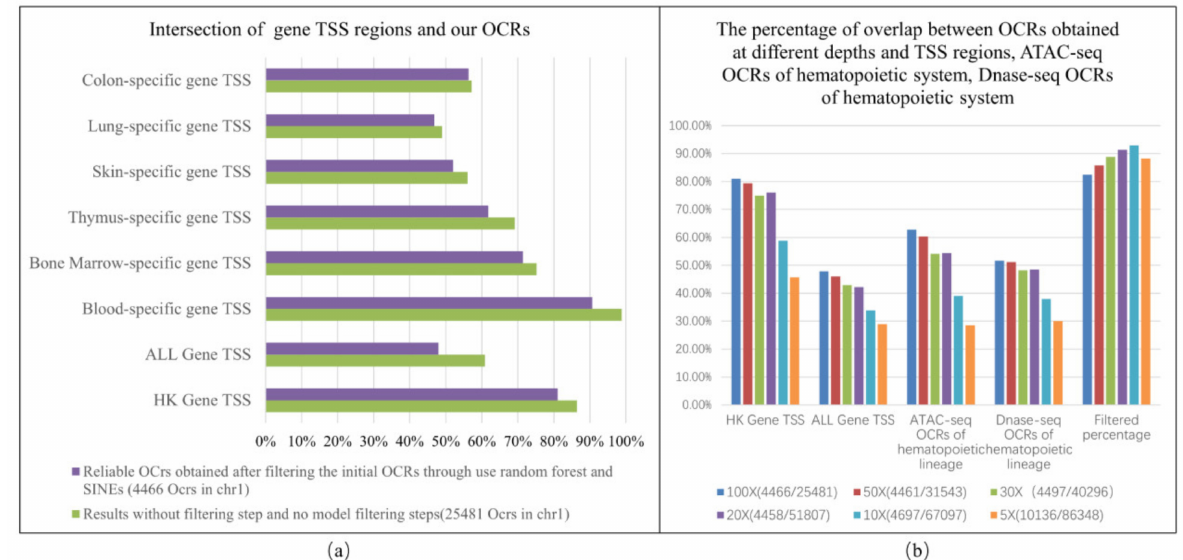
Figure 3. ( a ) The intersection of gene TSS regions and OCRs obtained under different filter conditions. ( b ) The percentage of overlap between our OCRs obtained at different coverages and TSS regions, the ATAC-seq OCRs of the hematopoietic system, and the DNase-seq OCRs of the hematopoietic